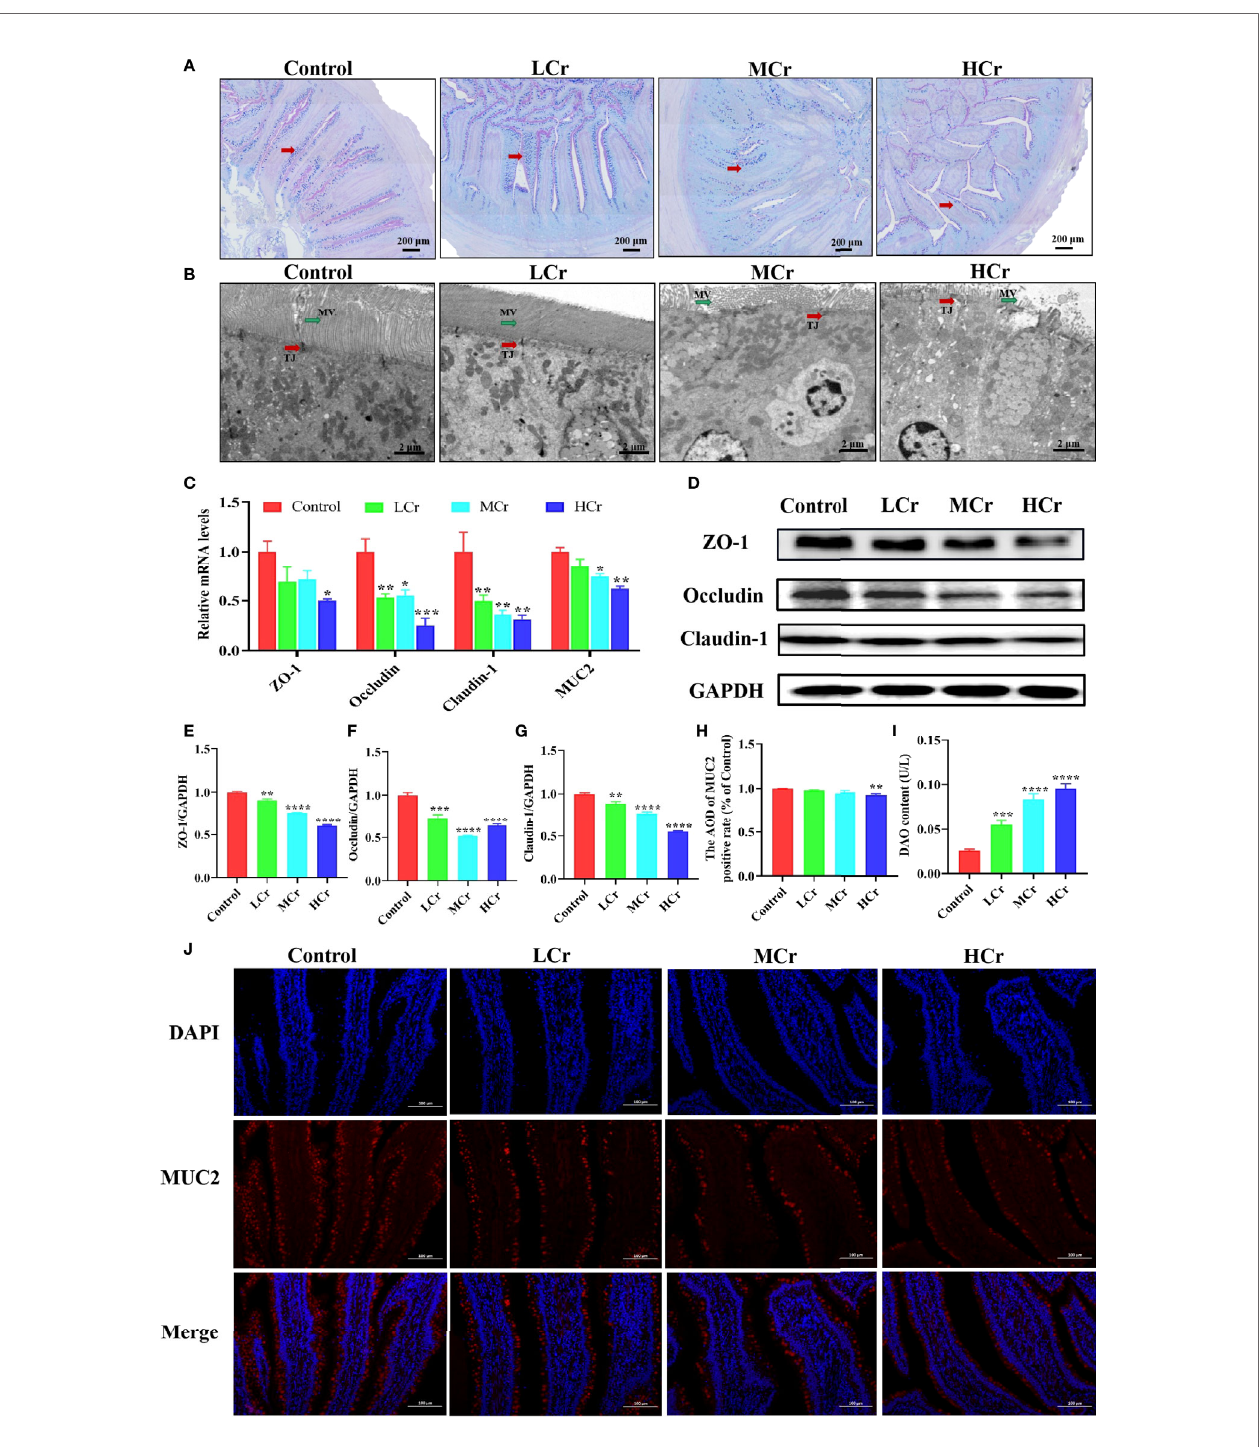
FIGURE 2 | Effects of Cr(VI) exposure on intestinal epithelial barrier function. (A) PAS staining was used to determine the distribution of goblet cells (red arrows) in the intestine (scale bar = 200 m m). (B) Ultrastructure of the jejunum (scale bar = 2 m m). The red and green arrows represent changes in tight connections and microvilli, respectively. TJ stands for tight connection; MV stands for microvilli. (C) mRNA levels of genes related to the intestinal barrier. (D – G) Effects of Cr(VI) exposure on tight-junction protein expression levels in the duck jejunum. (E) ZO-1/GAPDH. (F) Occludin/GAPDH. (G) Claudin-1/GAPDH. (H) ImageJ analysis of MUC2 immuno fl uorescent staining results. (I) DAO content. (J) Immuno fl uorescence staining of MUC2 protein expression in jejunum tissue. The symbol “ * ” denotes a statistically signi fi cant difference from the control group (* P < 0.05, ** P < 0.01, *** P < 0.005 and **** P <